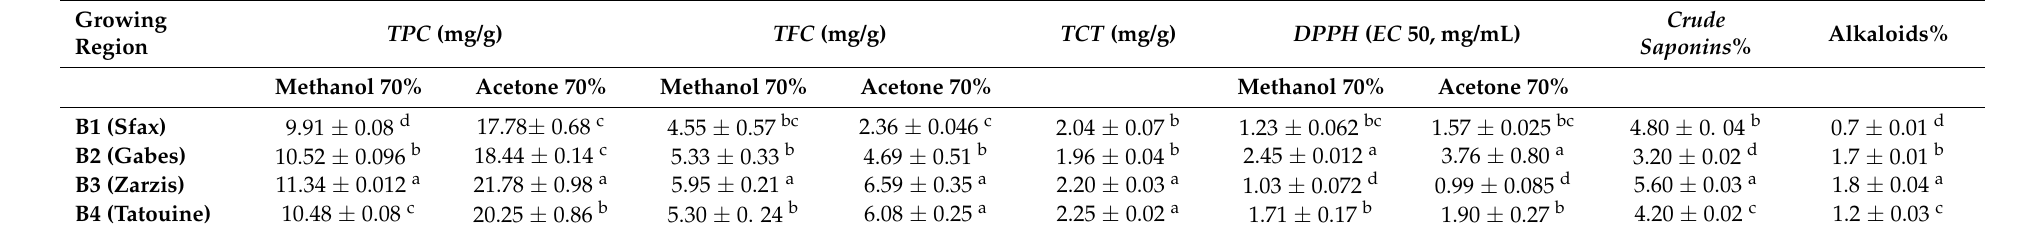
Table 1. Phytochemical composition of plant extracts of five wild populations of Brassica tournefortii leaf extracts.